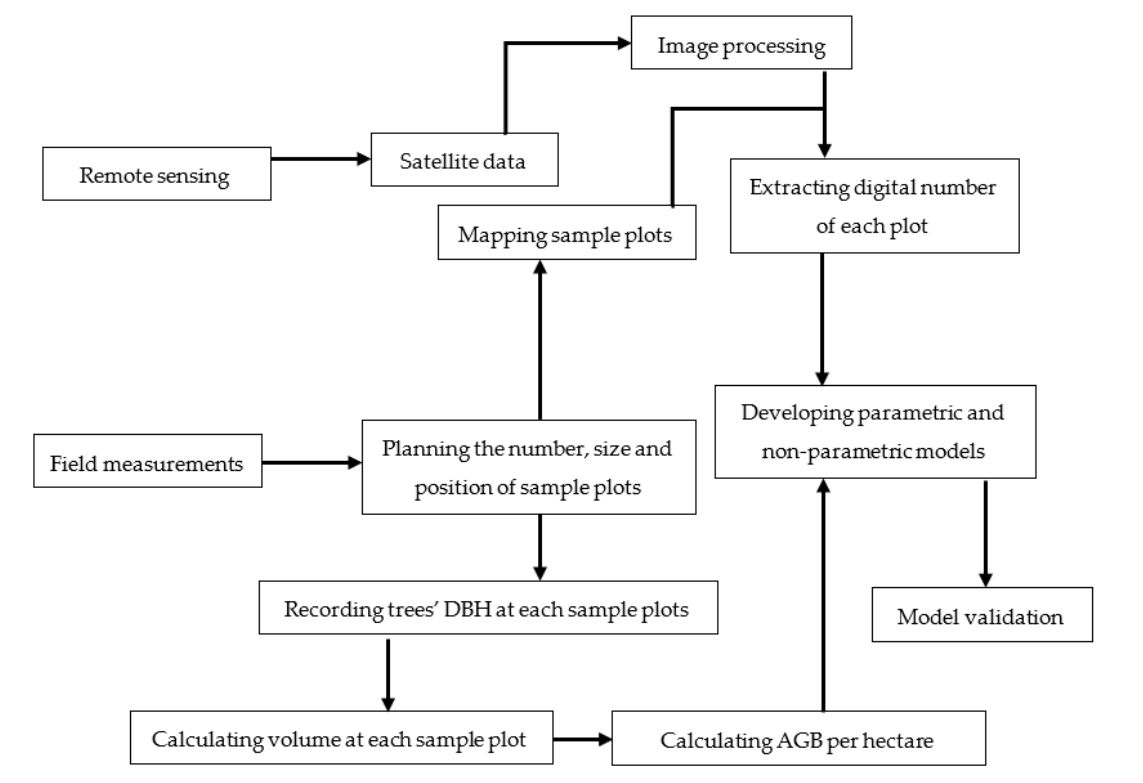
Figure 2. The flowchart of AGB estimation methods used in the study.